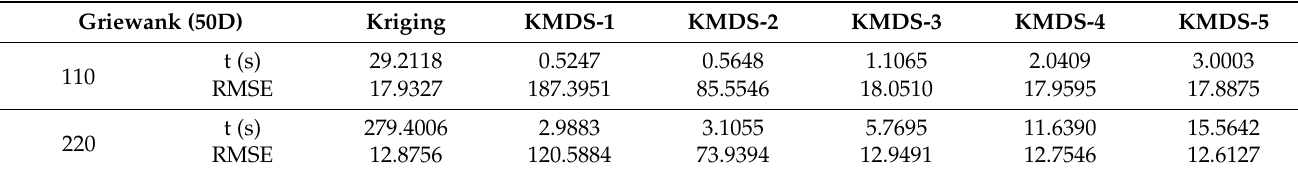
Table 1. Modeling time and accuracy of Kriging and KMDS